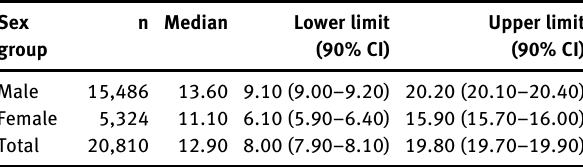
Figure 2: Box-plot of the serum level of homocysteine (Hcy) for different age-groups. The whiskers of the box plot were 1.5 times the interquartile range from the box. Table  : Reference intervals of Hcy for apparently healthy adult population.